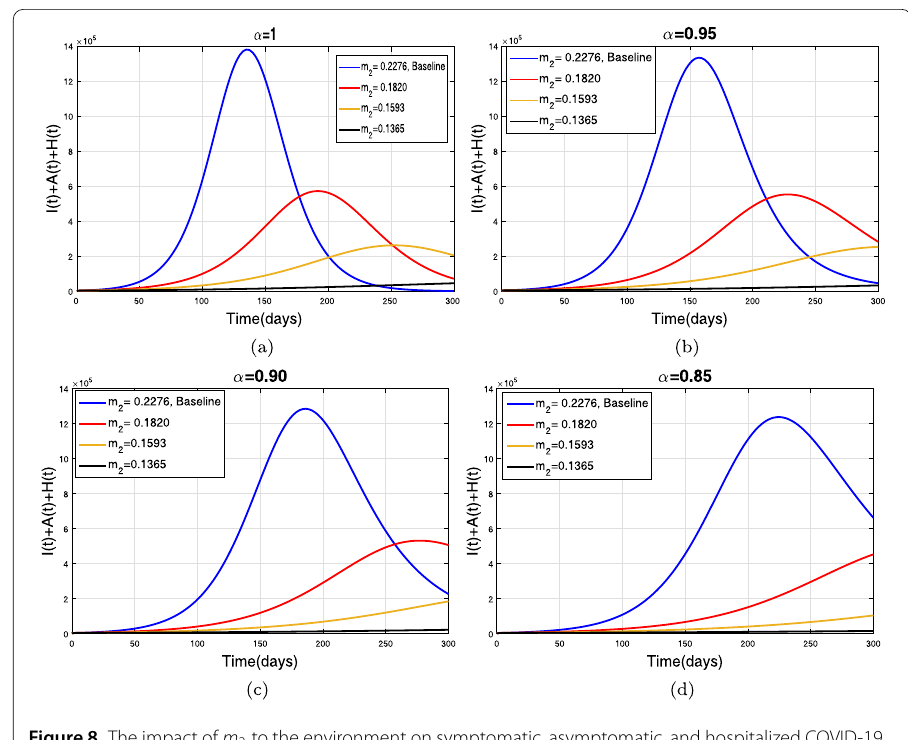
Figure 8 The impact of m 2 to the environment on symptomatic, asymptomatic, and hospitalized COVID-19 individuals for α = 1, α = 0.95, α = 0.90, α = 0.85